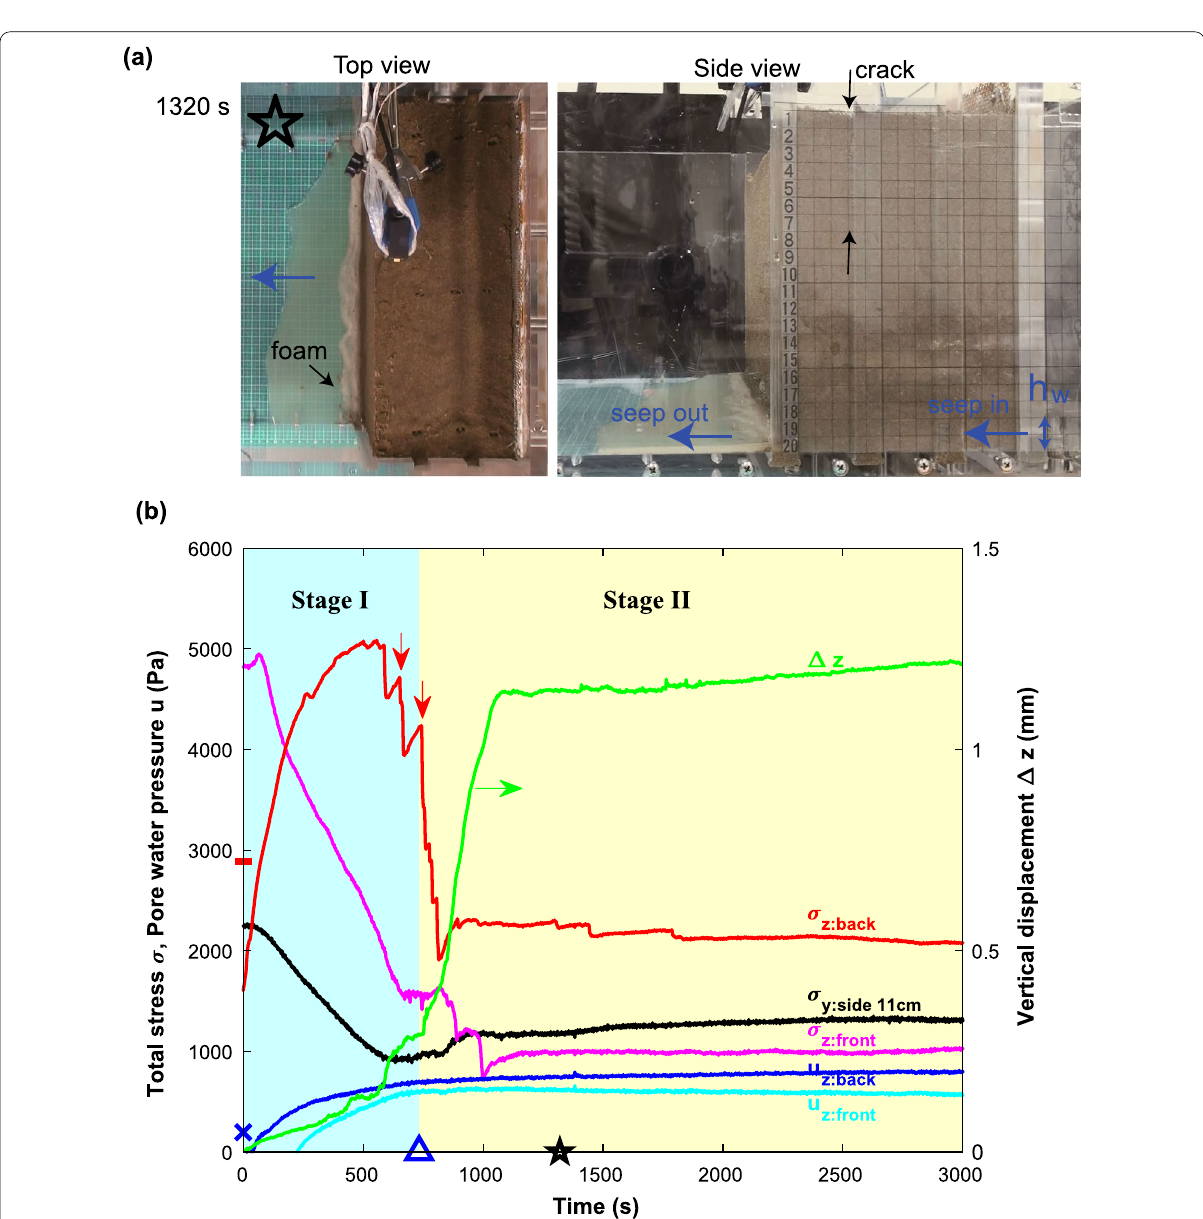
Fig. 4 Results of the h w = 2 cm case (run 8, H = 20 cm, h w / H = 0.10 ), in which no slide is triggered. a Images at t = 1320 s, and b time-series data (5-point running averaged) of total stress σ , pore water pressure u (left axis), and vertical displacement (cid:31) z (right axis). Back, front, and side indicate the sensor positions, and subscripts y and z indicate the normal direction (see Fig. 2b). A blue (cid:31) is the seepage time T seep , which defines the onset of stage II. A star indicates the t = 1320 s when the images shown in a were taken. The red vertical bar and blue × (left axis) indicate the reference σ range, σ 0 ≤ σ ≤ ˜ σ 0 [Eqs. (5), (6)], and the u = u 0 [Eq. (7)],